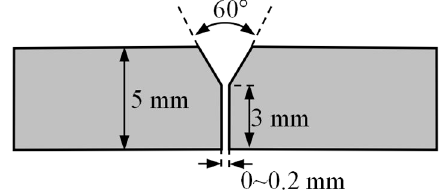
Figure 1. Groove shape and size.